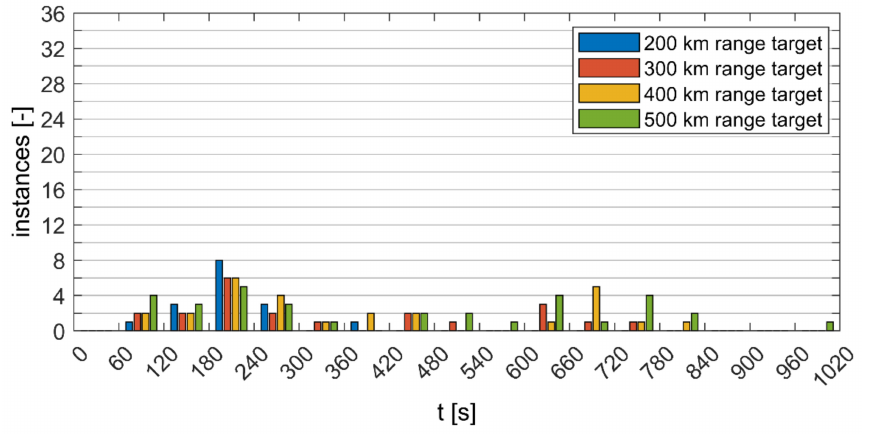
Figure A4. REX engagement instances binned by engagement time for WLTC 3b and vehicle mass of 2100 kg.